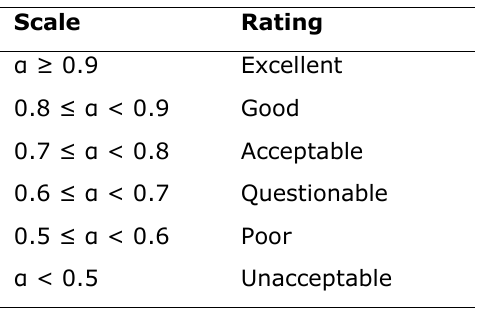
Table 4: Cronbach’s Coefficient Alpha Ranges